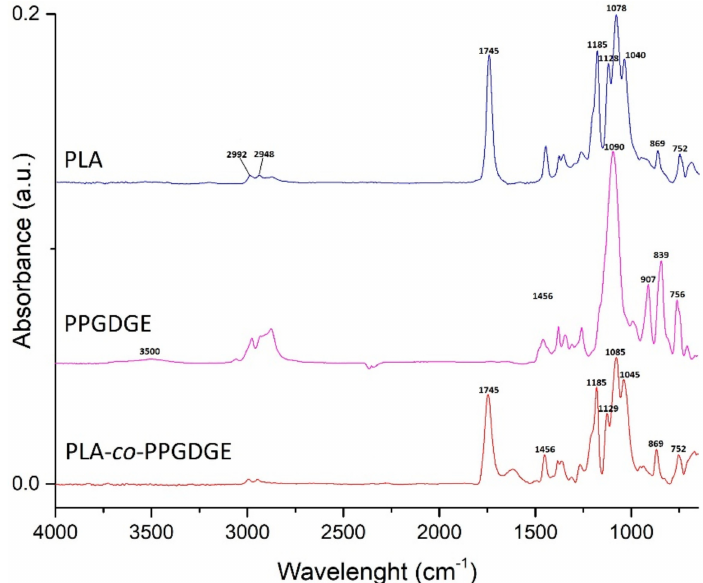
Figure 2. FTIR spectra of: PLA, PPGDGE, PLA and PLLA-co-PPGDGE. Copolymer ratio PLA/PPGDGE